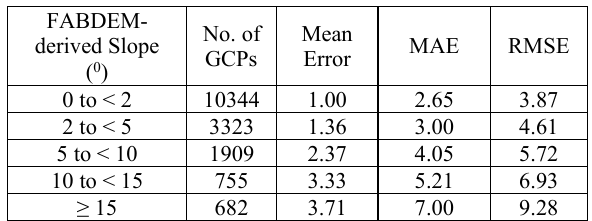
Table 7. The FABDEM accuracy statistics computed using all the GCPs located at different slope classes (unit: meters).